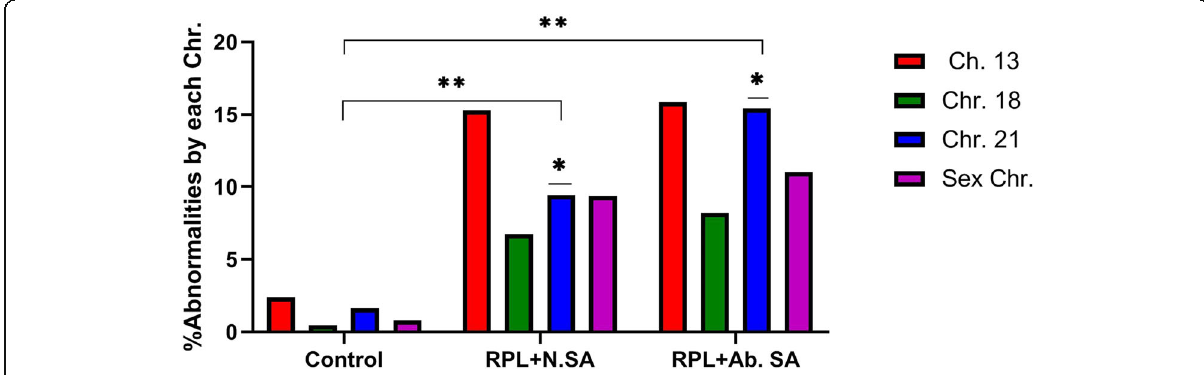
Fig. 1 Comparison of aneuploidy by each chromosome in men with RPL normal SA, abnormal SA, and normospermic men. *Significant difference between RPL men with normal and abnormal semen was shown just according aneuploidy in chromosome 21 ( p < 0.05). **But aneuploidies in all investigated chromosomes were significantly different between two RPL groups comparing to control group ( p < 0.0001). RPL: recurrent pregnancy loss; N.SA: normal semen analysis; Ab.SA: abnormal semen analysis; Chr: